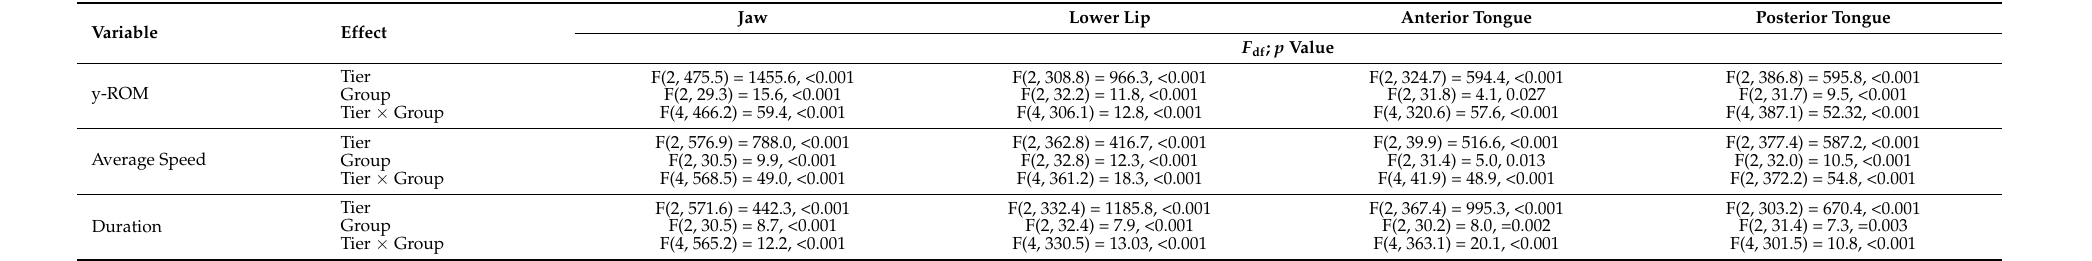
Table 3. Statistical findings of linear mixed models.